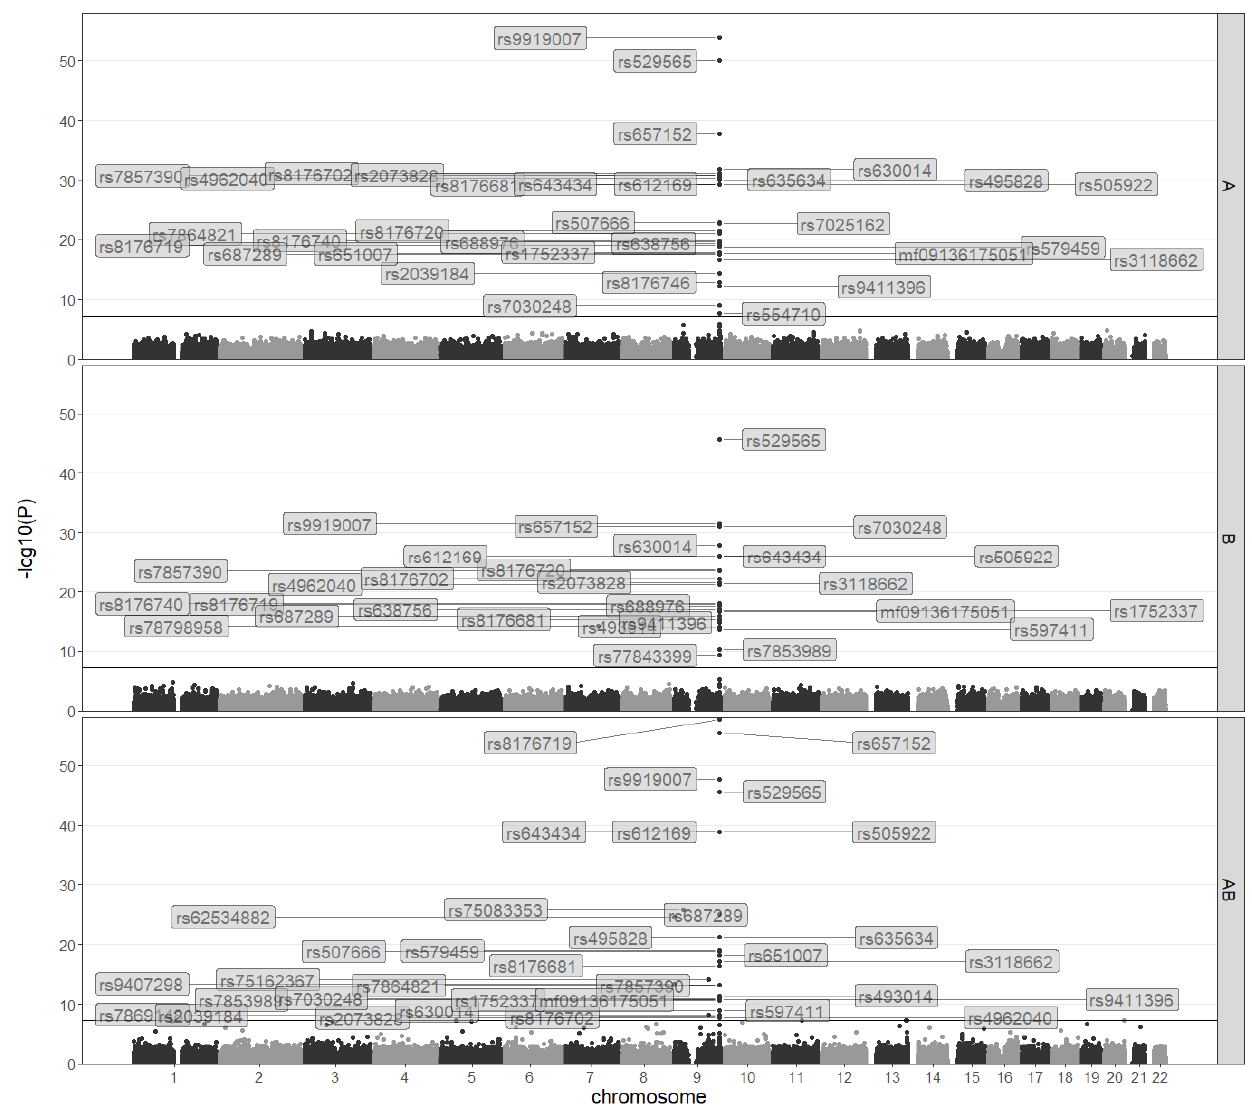
Figure 1. Manhattan plots for the quaternary (4-level, reference level of type O) outcomes of A vs . O (upper), B vs . O (middle) and AB vs . O (lower) in the cohort. Genome-wide hit SNPs (above the horizontal line) are annotated.